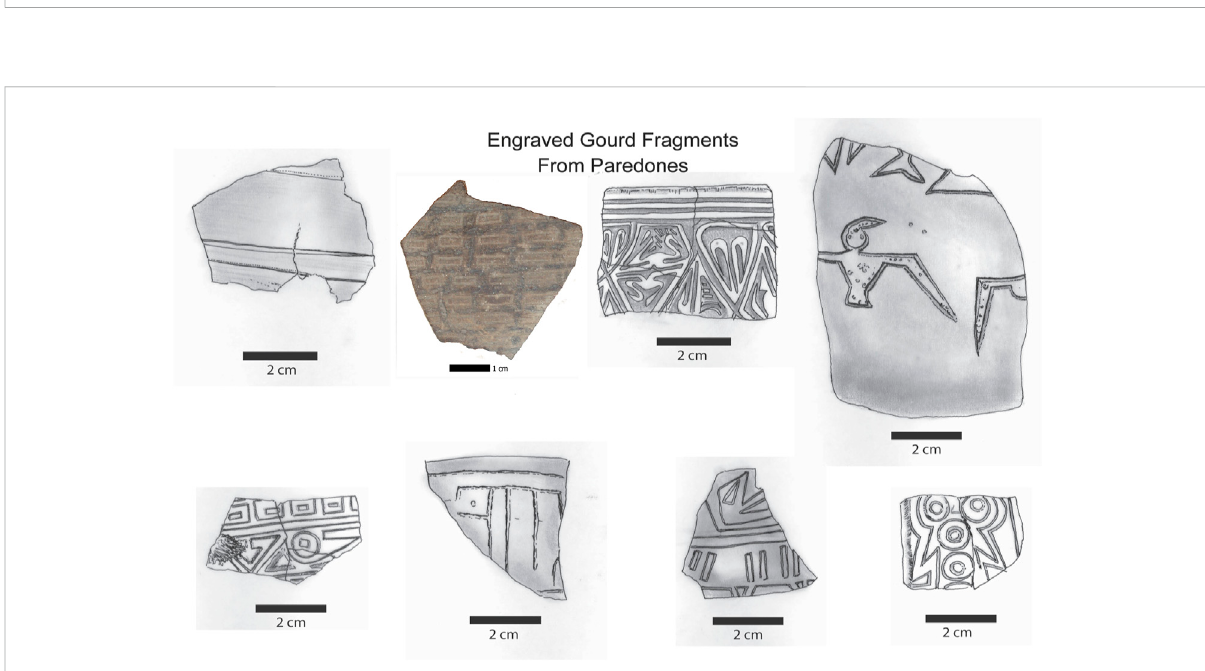
Schematic reconstruction of cotton textile with tightly woven design dated to about ~5200 BP.